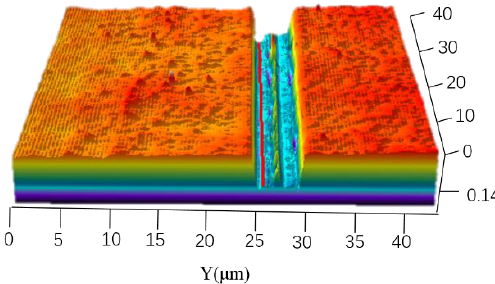
Coatings 2019 , 9 , x FOR PEER REVIEW Figure 7. 3-D distribution of optimal surface morphology. Figure 7. 3-D distribution of optimal surface morphology.